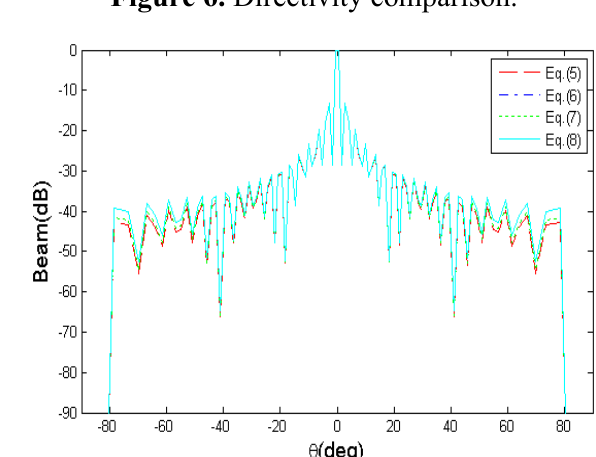
Figure 6. Directivity